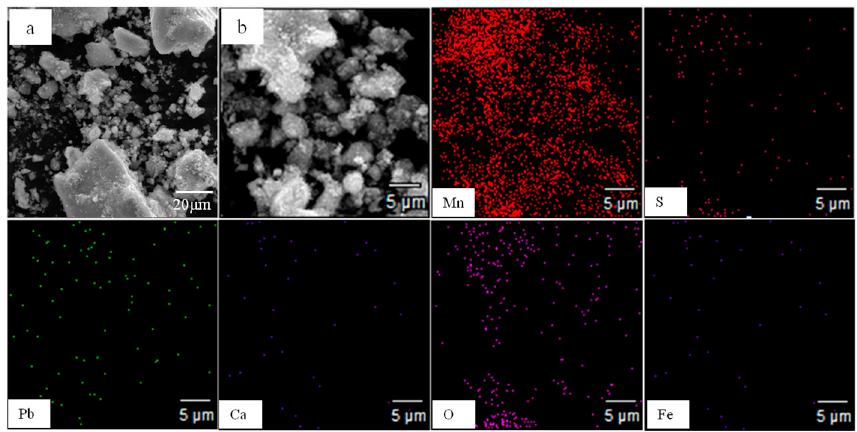
Figure 2. Scanning electron microscopy (SEM) and element distribution map of the electrolytic manganese anode mud. ( a ): SEM at low magnification under conventional conditions; ( b ): a partial enlarged view of ( a